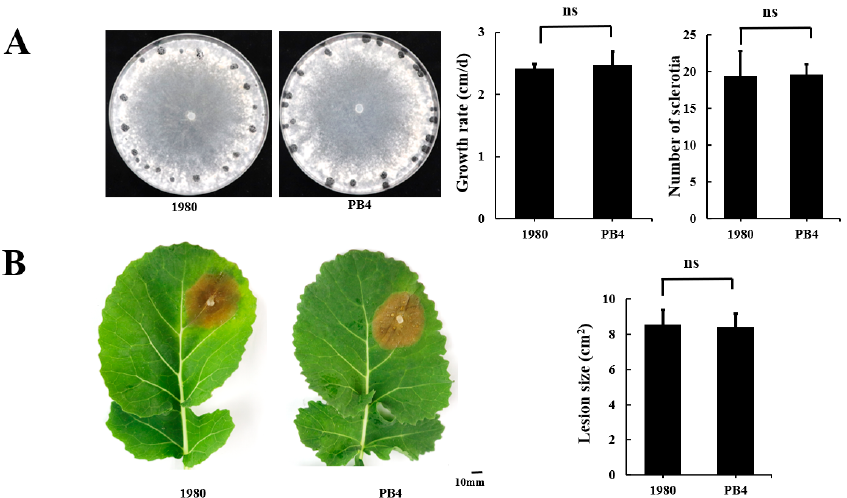
Figure 1. The biological characteristics of Sclerotinia sclerotiorum strains PB4 and 1980. ( A ) Colony morphology, hyphal growth rate, and the number of sclerotia formed. All strains were cultured on PDA plates at 20 °C for 15 days before photography. ( B ) Pathogenicity on detached leaves ( Brassicae napus ) 48 h post inoculation. ns means no significant.